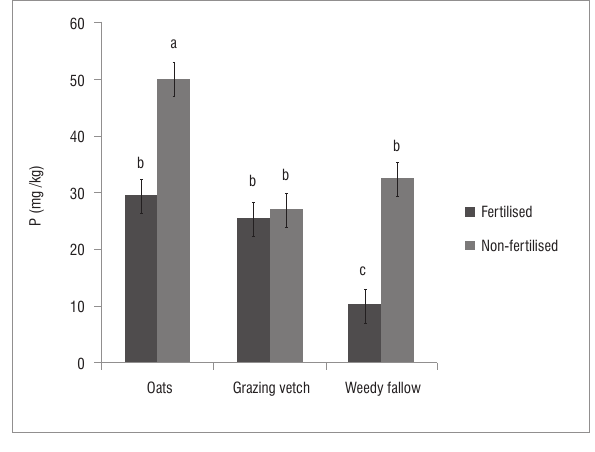
Figure 2: Interaction effects of winter cover crop type and fertiliser on humic acid-P.